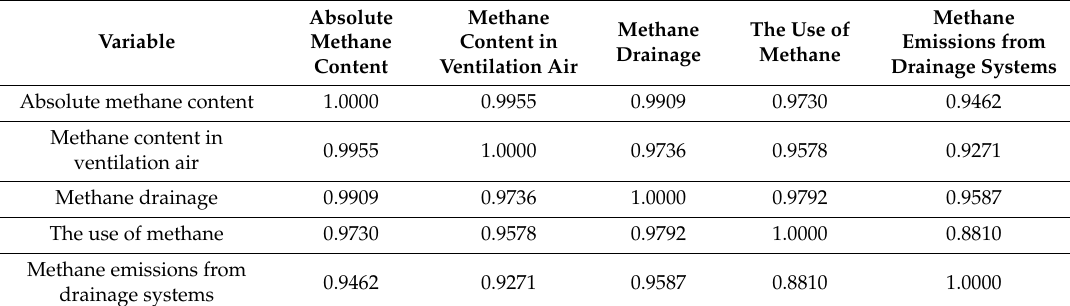
Table 4. The matrix of the correlation coe ffi cients between the variables under analysis for the methane extraction and emission from Polish hard coal mines between 1993–2018 per one ton.